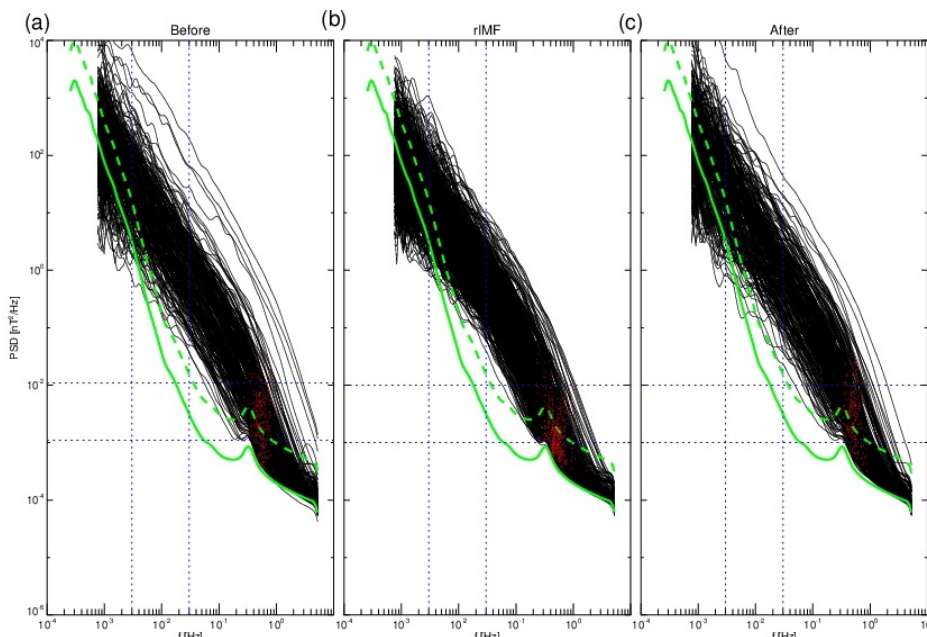
Figure 3. PSD profiles computed in all selected 1-h intervals: ( a ) before the radial IMF events, ( b ) in the radial IMF events, and ( c ) after the radial IMF events. The black dotted lines mark the intervals for calculations of the PSD slopes in the MHD (vertical) and kinetic (horizontal) scales. The solid and dashed green lines represent the noise floor and 5 times of the noise floor, respectively. The red points denote the inertial length frequency for each interval.